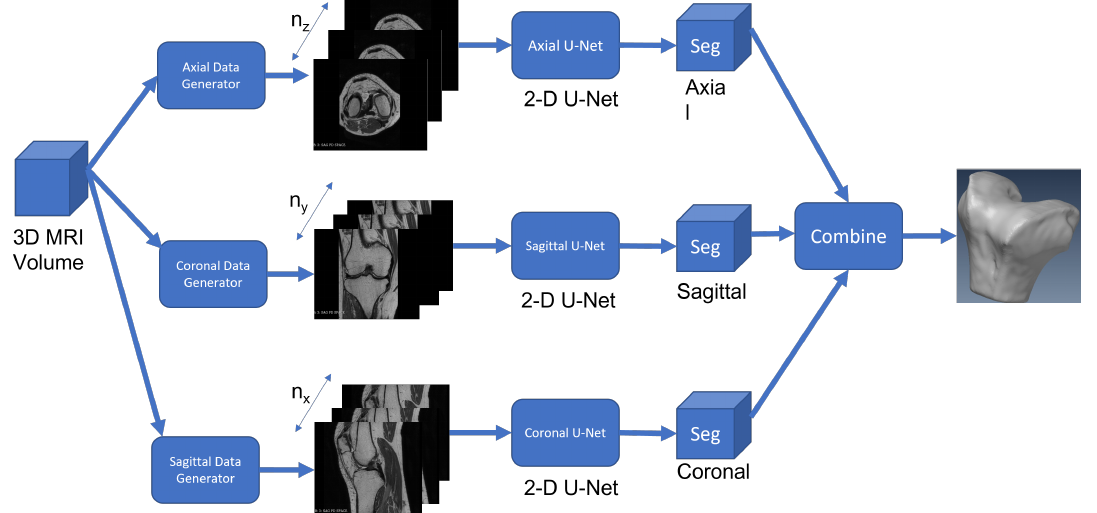
Figure 7. The 2.5D U-Net